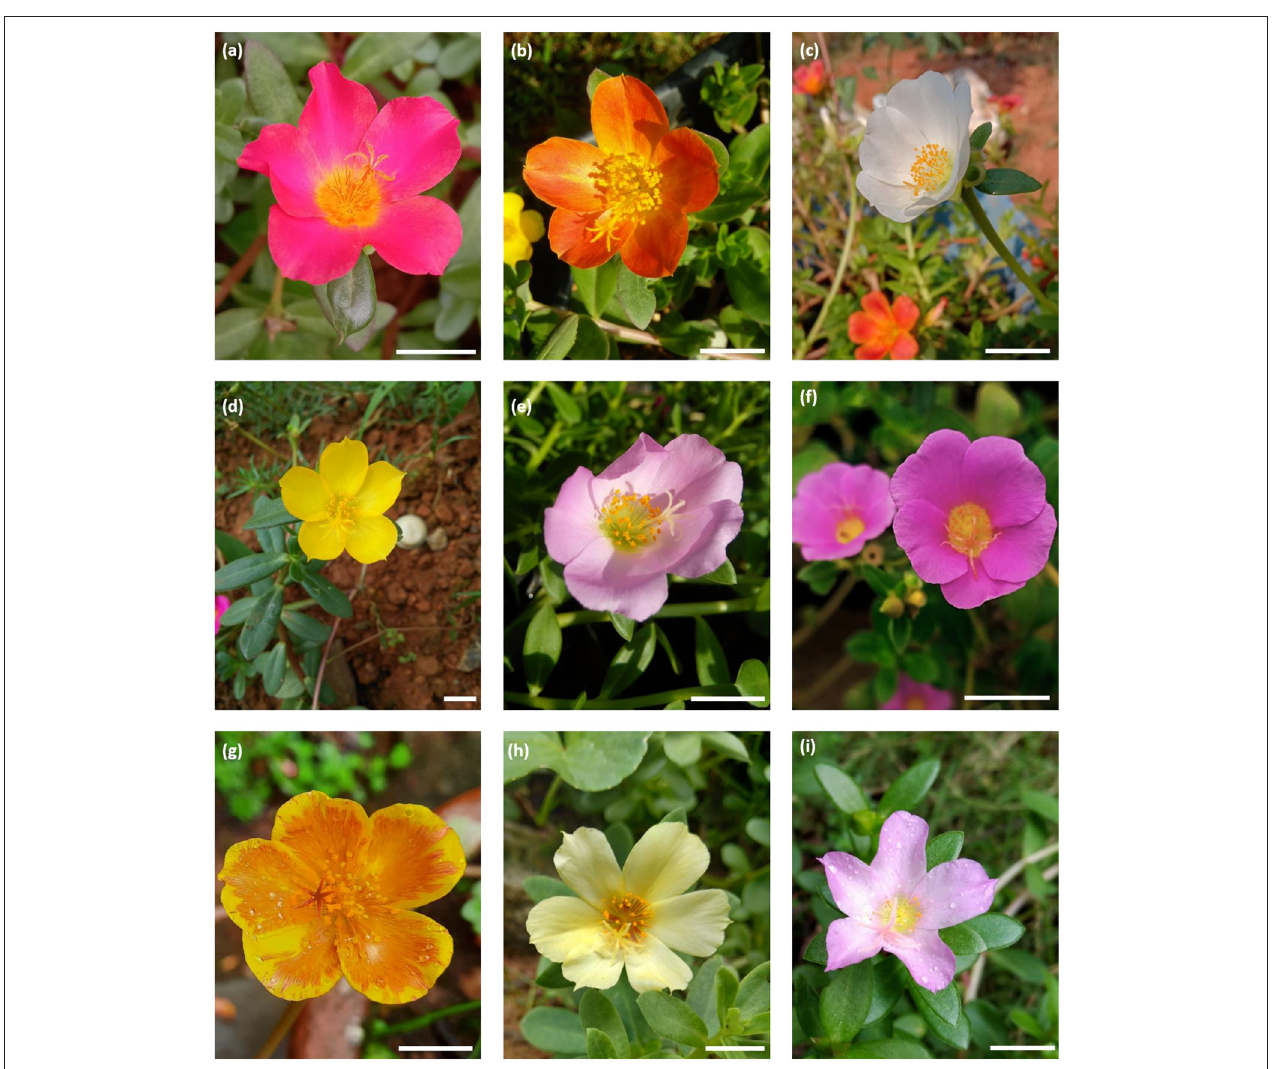
FIGURE 2 | (a–i) Morphological diversity of flowers observed in purslane (scale bar,